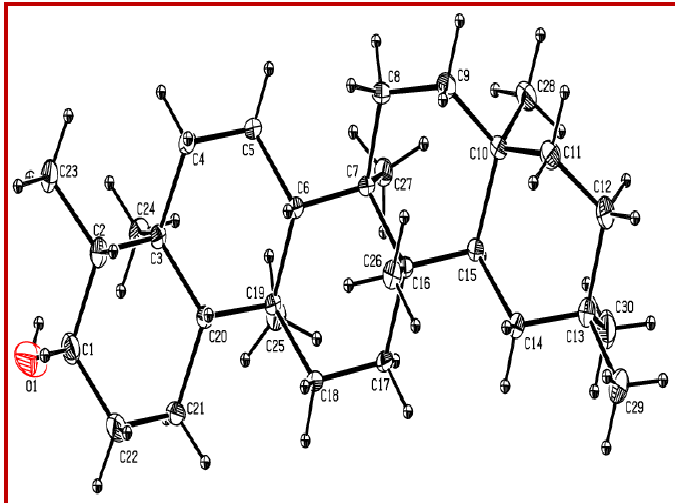
Figure 1: Crystal structure of epifriedelanol showed the atom position on the structure